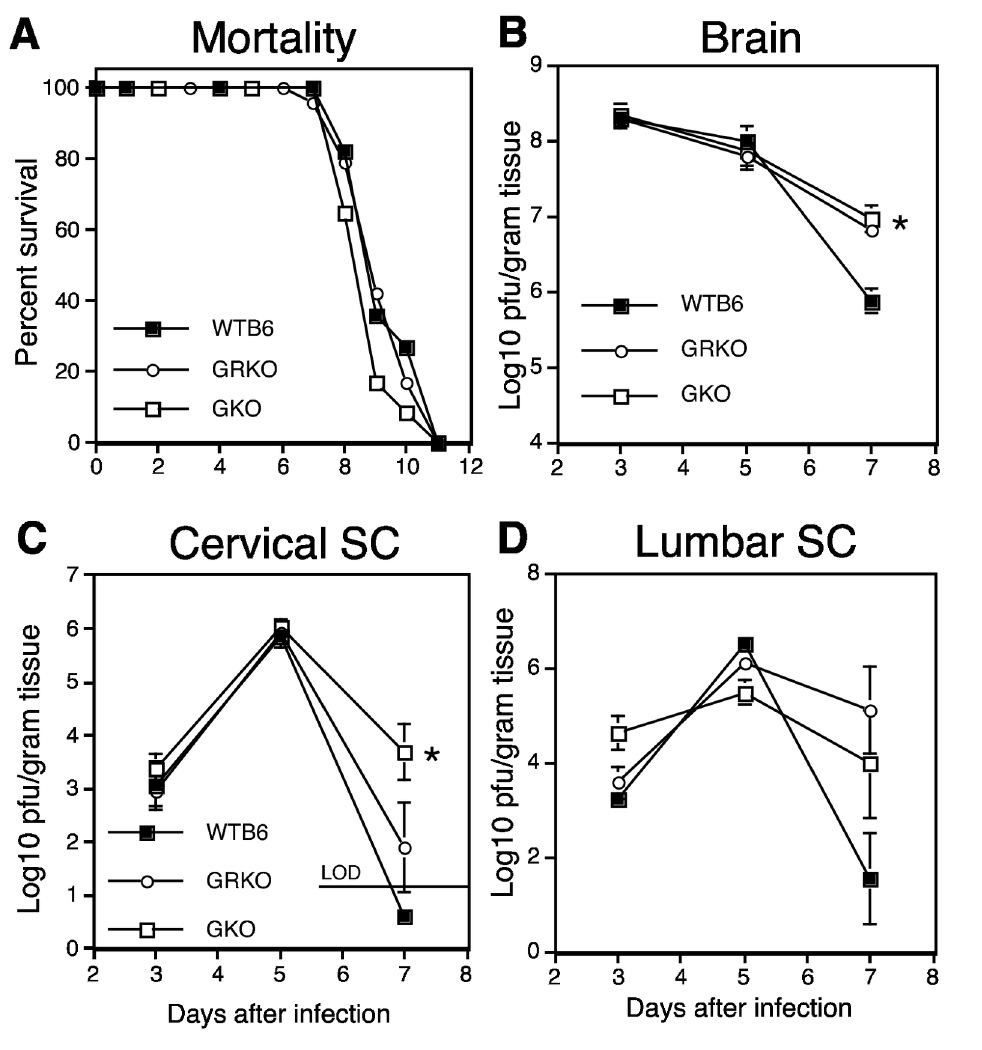
Figure 1. Mortality and virus replication after intranasal NSV infection. (A) 6-9 week-old WTB6 ( N = 11), GKO ( N = 24) and GRKO ( N = 23) mice were infected intranasally with 10 5 pfu NSV and followed daily for mortality which was similar. P = 0.47. At 3, 5, and 7 d after infection, brains (B), cervical (C) and lumbar (D) spinal cords from 3 WTB6, GKO or GRKO mice were assayed